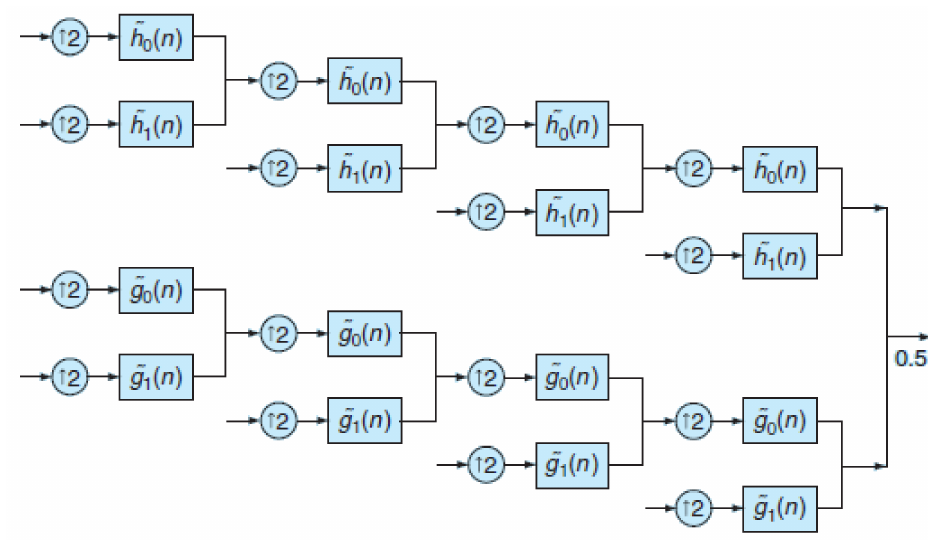
Figure 1. Dual-tree discrete CWT decomposition.